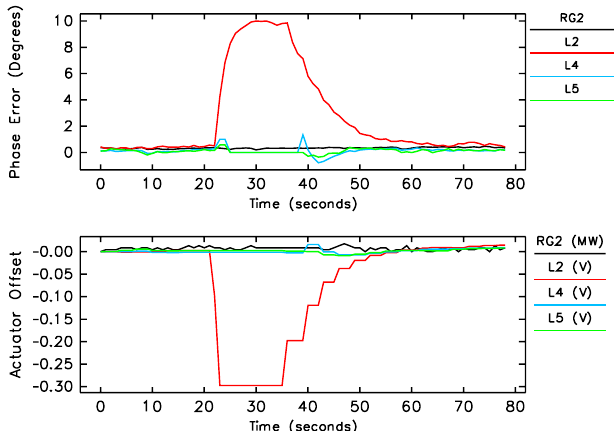
FIG. 9. (Color) Linac phase feedback operation for the case of a phase error generated by a momentary change in the L2 phase voltage actuator. The feedback loop is turned on approximately 35 seconds into the test. Operation is similar for L4 and L5 feedback